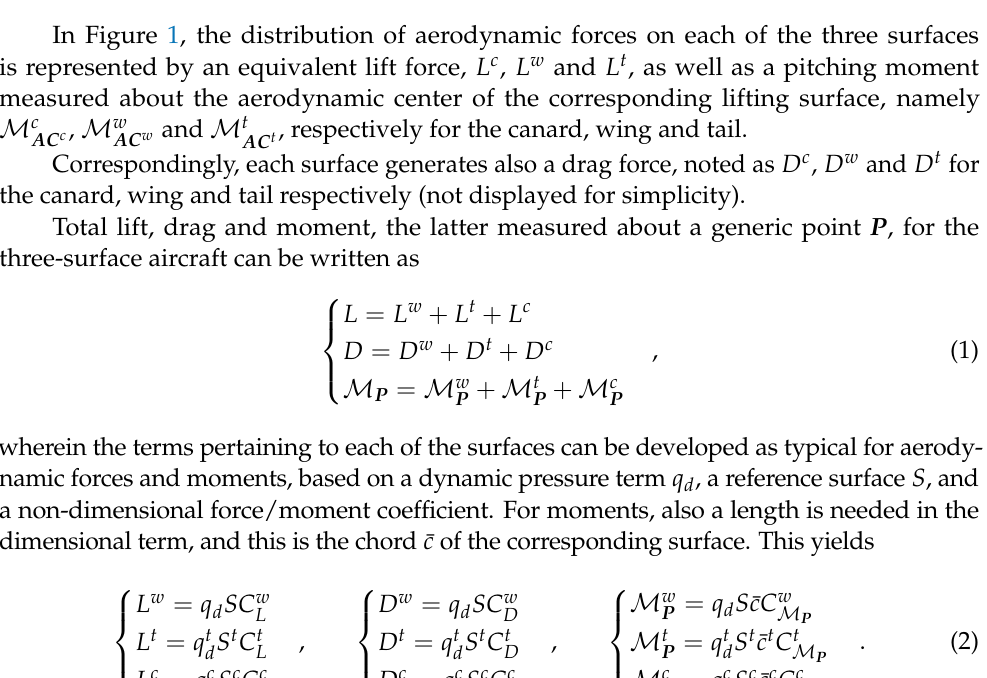
Figure 1. Three-surface model scheme for lift and pitching